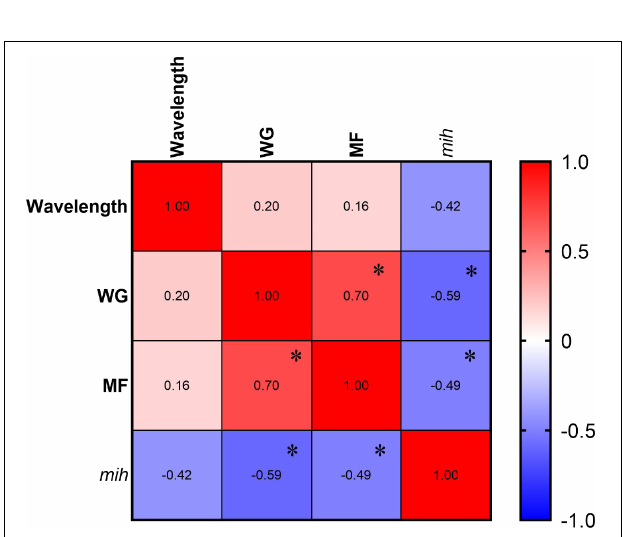
FIGURE 10 | Correlation analyses among wavelength and WG, MF, and relative expression of mih ( n = 3, 2 individuals per replicate of mih , and n = 3 replicate; and 34, 31, 37, 37, 35, 32, and 34 individuals per treatment of WG and MF. The “ ∗ ” indicates P <